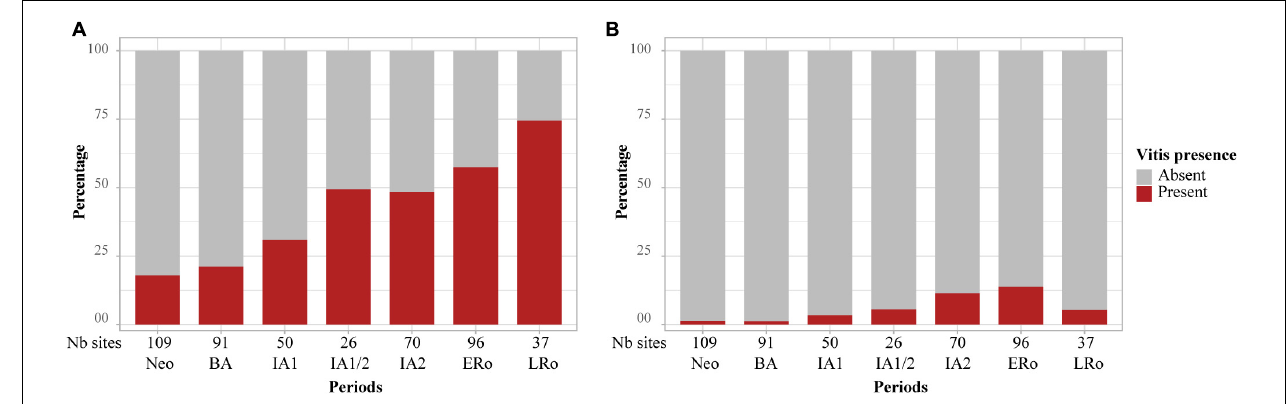
FIGURE 8 | Occurrence of Vitis remains in the charred archeological record in relation to cultural periods, (A) pips, (B) pedicels. Bar plots showing the proportion of sites which delivered Vitis remains. The number of sites for each period is provided at the bottom of the